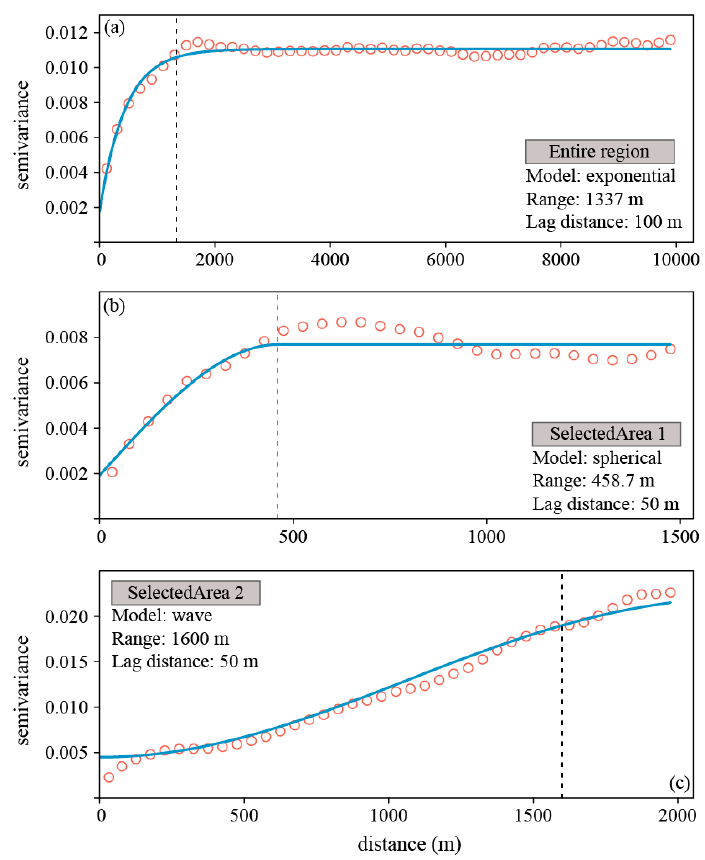
Figure 8. Empirical variograms (red circles) with fitted models (blue lines) for ( a ) the entire study region and ( b , c ) two selected representative areas. 300,000 pixels were randomly selected for the computation of empirical variogram for the entire region, while 100,000 pixels were randomly selected for each selected area.